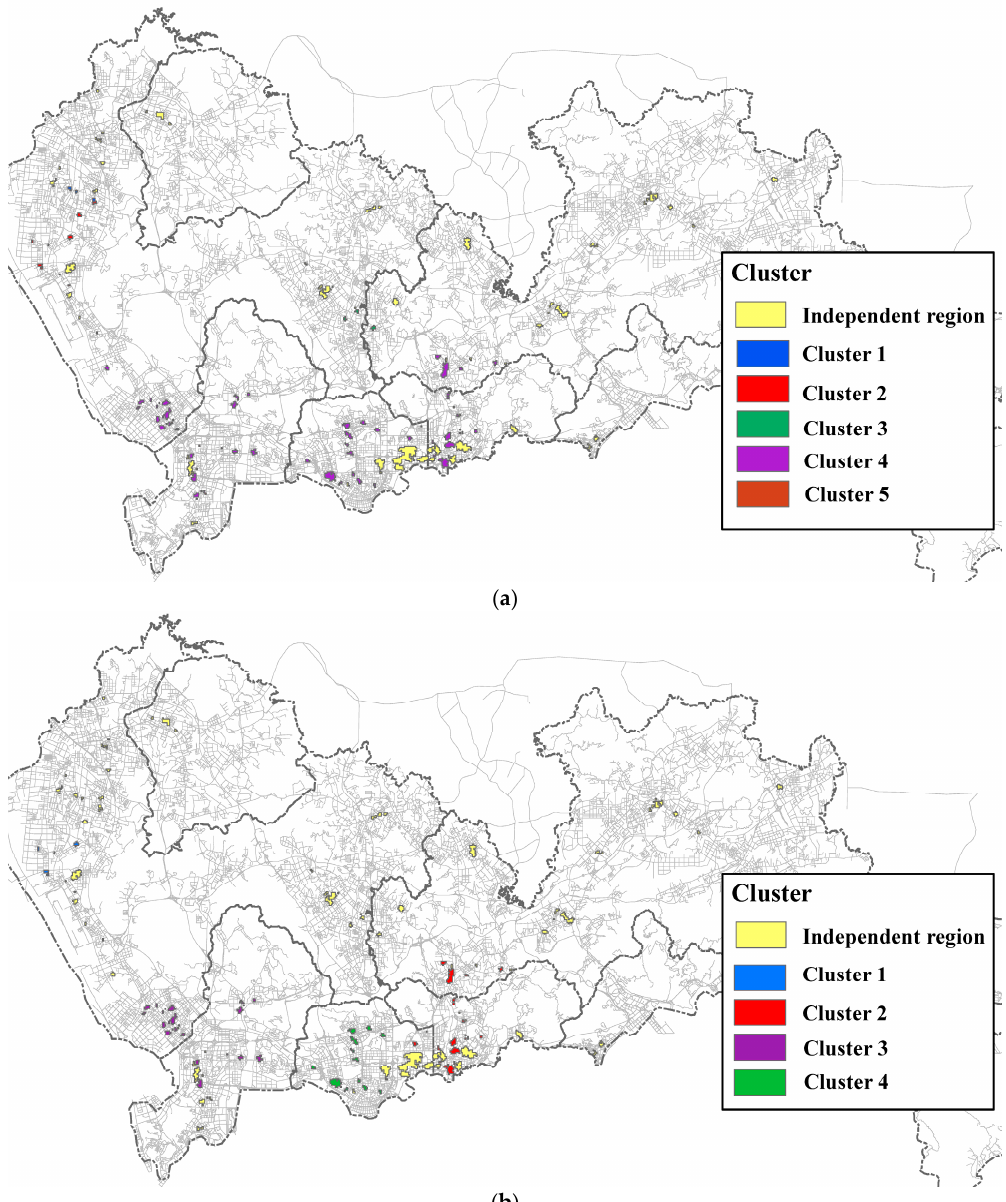
Figure 13. Results of clustering prevalent regions using the minimum number of polygons: ( a ) minPolys = 4; and ( b ) minPolys = 6, for the size-3 pattern {bank, retail store, hotel}. The bandwidth is 300 m.